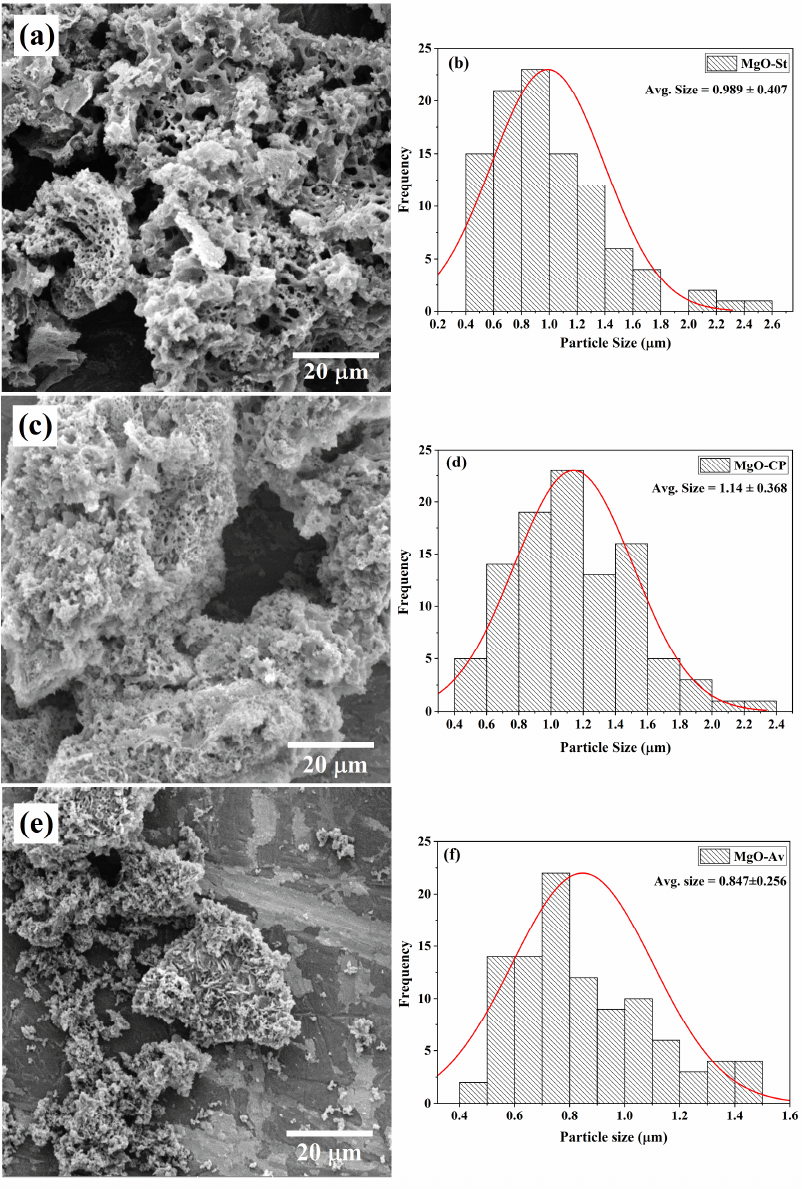
Figure 3. SEM images of synthesized MgO using different natural additives as fuel sources and average particle sizes of the samples: ( a , b ) MgO-St, ( c , d ) MgO-CP, and ( e , f ) MgO-Av.